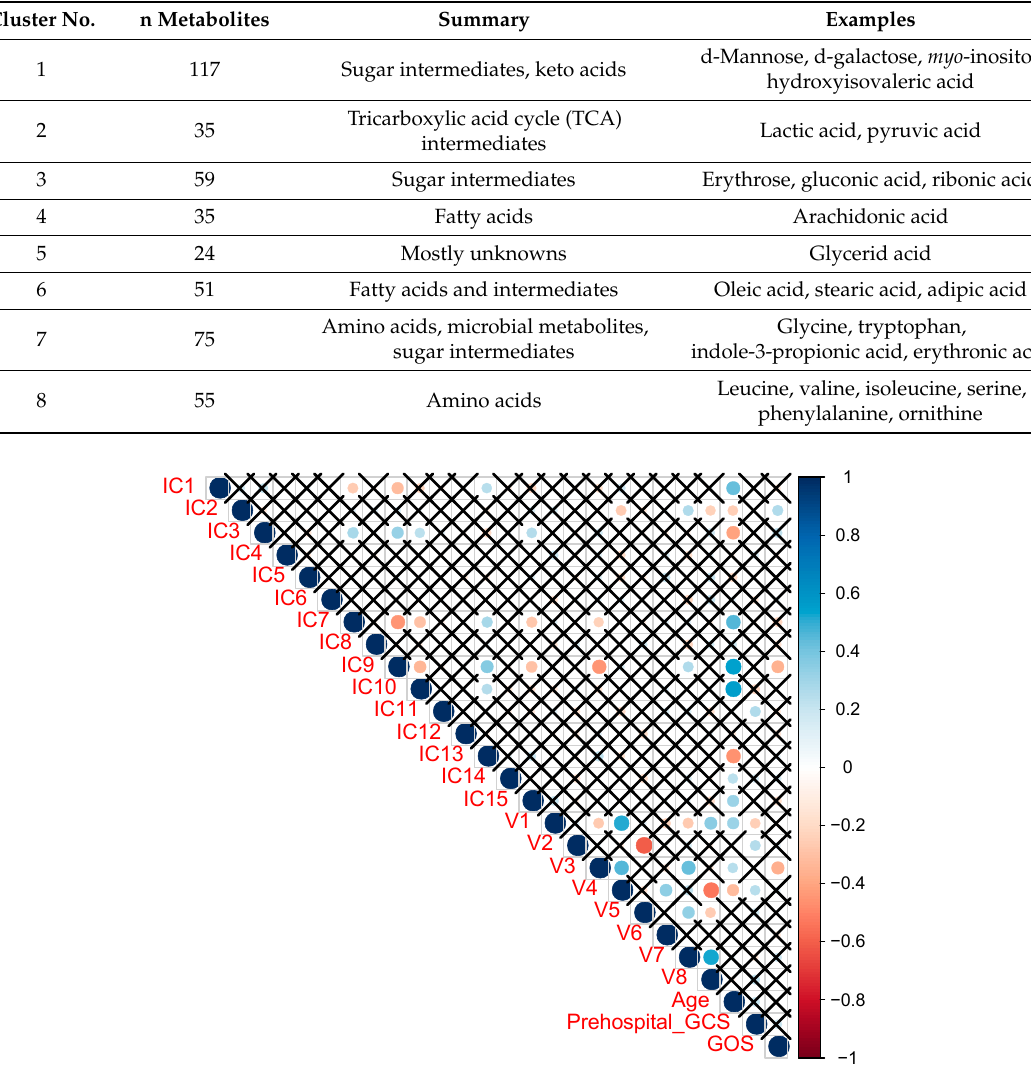
Figure 3. Correlations between four specific metabolite clusters (see Table 2) and sMRI data from different brain areas (on the scale to the left, from bottom to top: minimum to maximum). 2.2. Metabolites Associate with Positive sMRI Findings In order to see if the metabolites were also able to predict the need for a MRI scan, we evaluated associations of metabolites with visible sMRI positive/negative findings using a random forest model [25,26]. The metabolites were sorted based on their influence on the mean Gini decrease index [27]. Higher values of mean Gini decrease index indicate higher variable importance, when predicting a target variable. It is virtually a weighted average of the importance of the specific variable across all decision tress that make up the random forest. In total, 31 metabolites were selected (MeanDecreaseGini > 0.2) (Figure 4). The more important a variable, the higher it is ranked in Figure